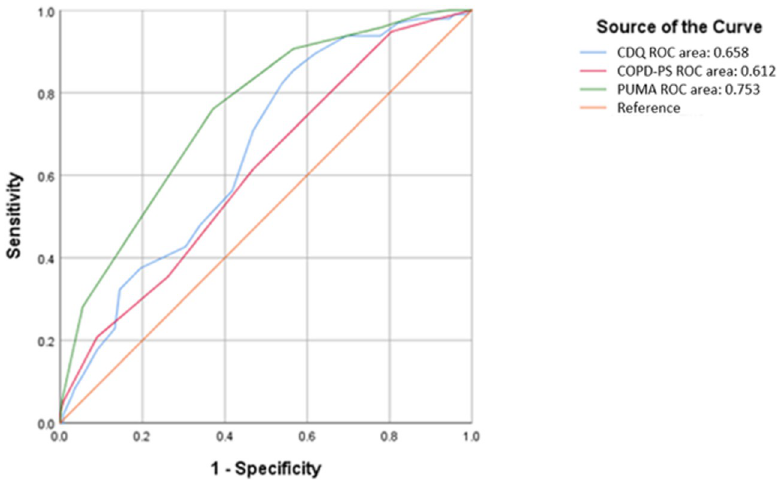
Fig 1. Area under the ROC for PUMA, CDQ and COPD-PS screening tools and COPD as outcome.